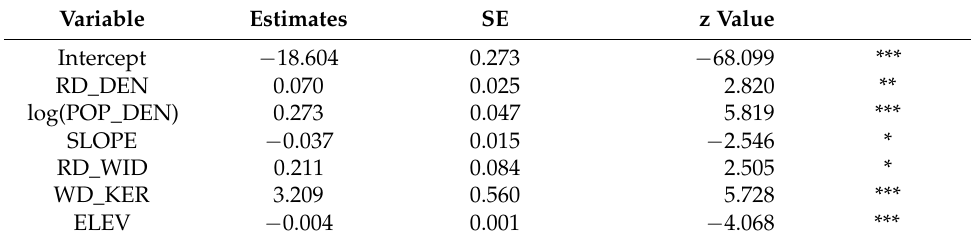
Table 4. Estimated model parameters for water deer roadkill (***: p < 0.001; **: p < 0.01; *: p < 0.05).